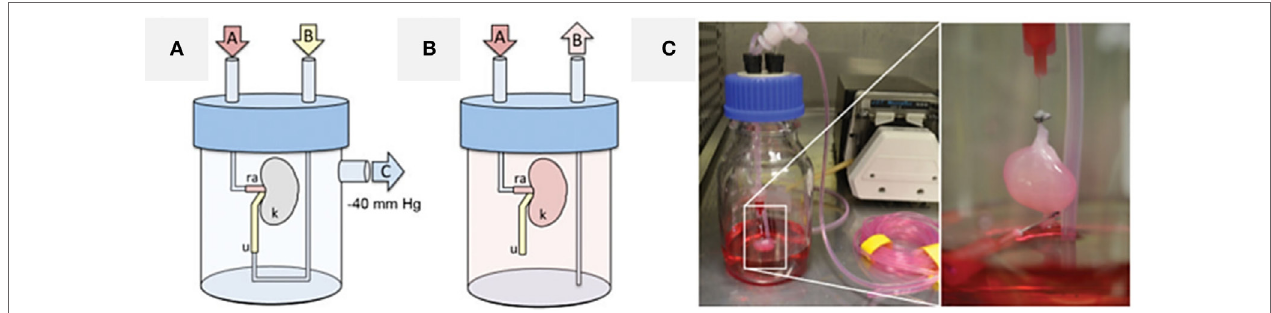
FiGURe 2 | Cell seeding and whole-organ culture of decellularized rat kidneys . (A) Schematic of a cell seeding apparatus enabling endothelial cell seeding via port A attached to the renal artery (ra) and epithelial cell seeding via port B attached to the ureter (u), while negative pressure in the organ chamber is applied to port C, thereby generating a transrenal pressure gradient (left). (B) Schematic of a whole-organ culture in a bioreactor enabling tissue perfusion via port A attached to the renal artery (ra) and drainage to a reservoir via port B (u, ureter; k, kidney). (C) Cell seeding of decellularized rat kidneys in whole-organ culture. Reprinted and modified with permission from Song et al.